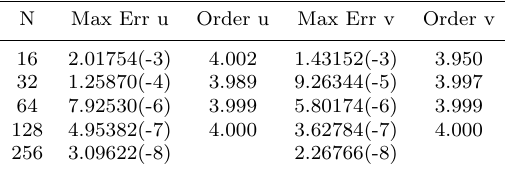
Table 6. Numerical results of Example